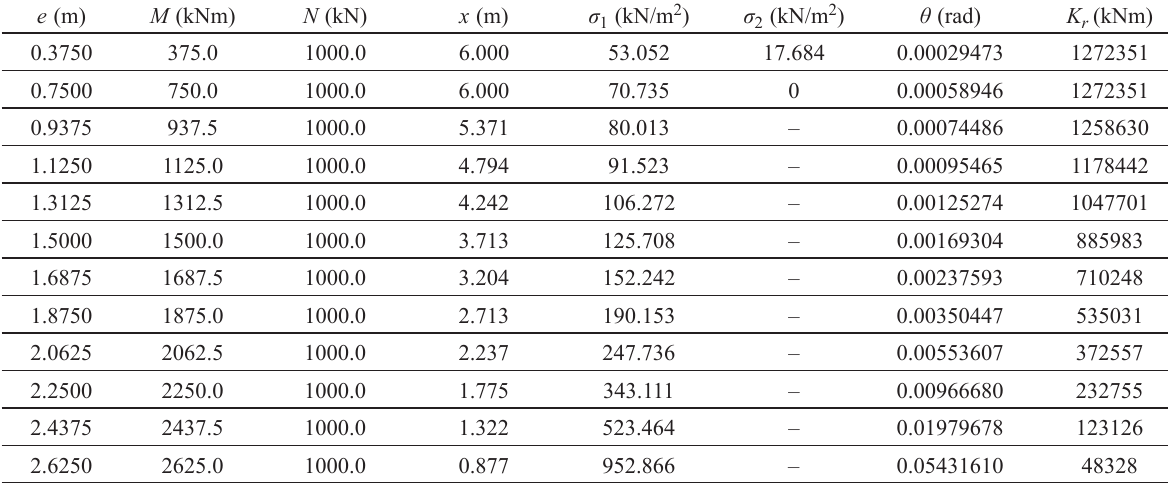
Table 1. Rotational spring constants of circular